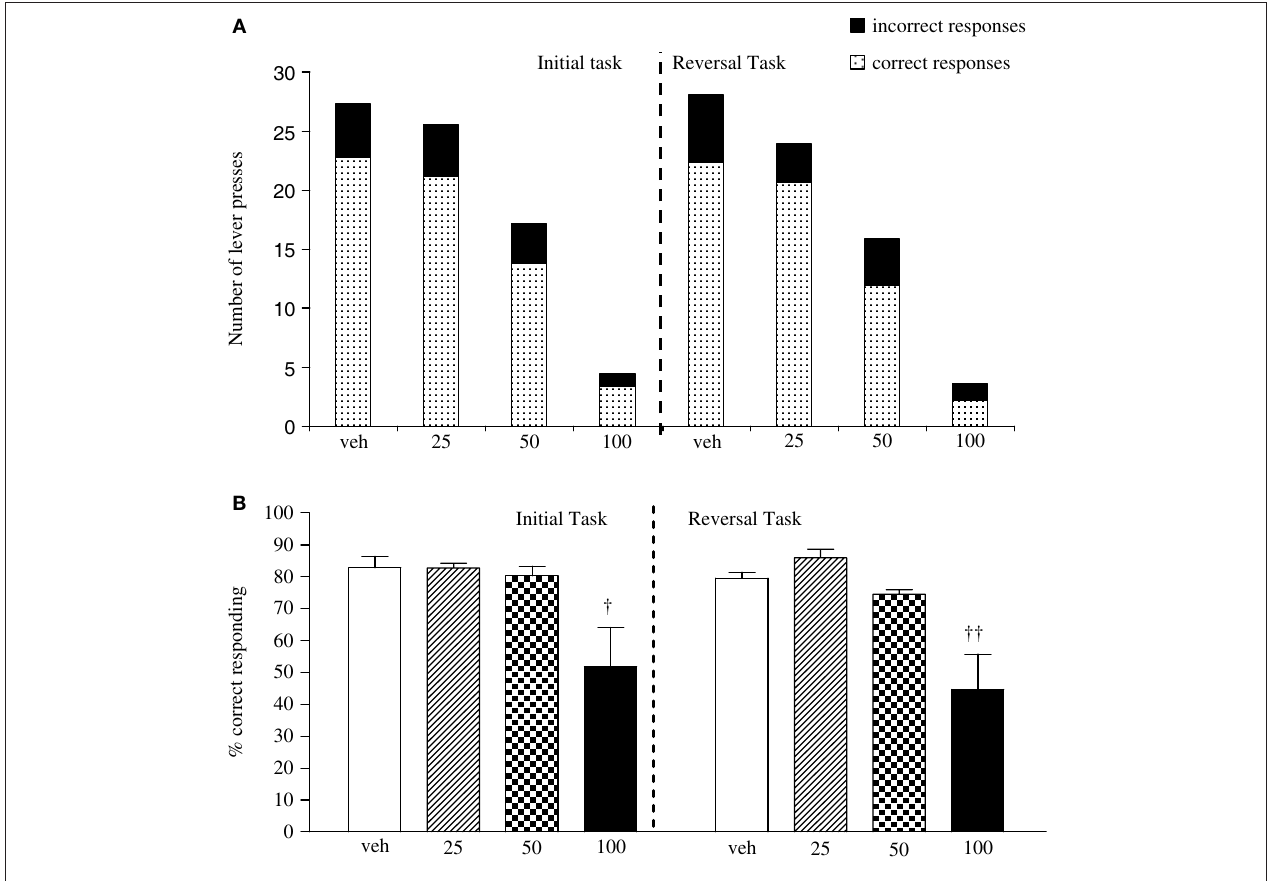
performance of the initial and reversal phase of the reversal learning task. Data are shown as mean ± S.E.M. percentage correct responding ( n = 10 per group). Signifi cant reduction in performance of the initial and reversal phase compared with the respective vehicle group; † P < 0.05, †† P < 0.01; ANOVA followed by Dunnett’s t